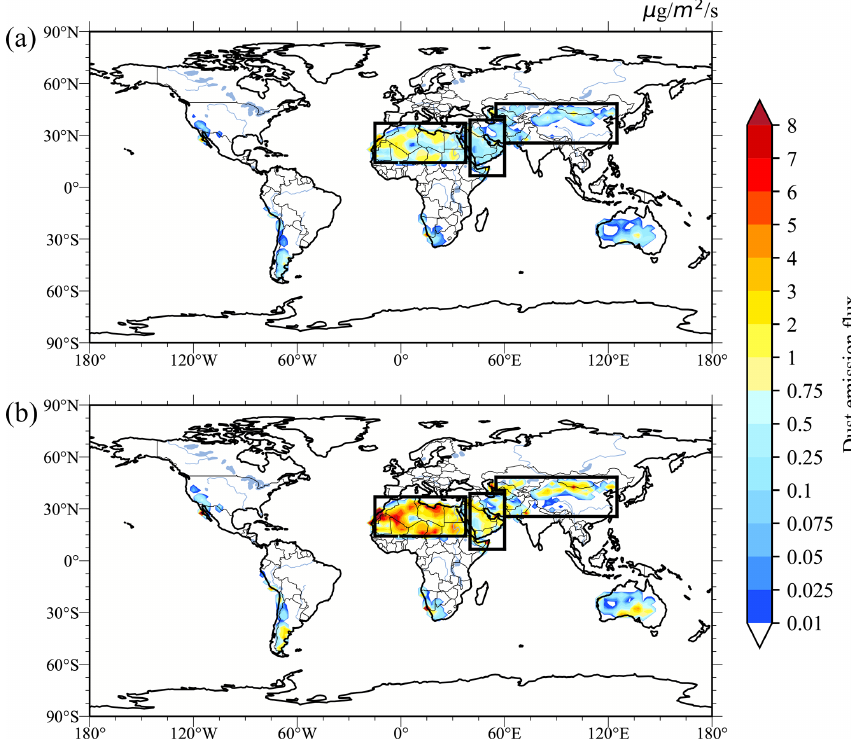
Figure 2. (a) Simulated annual emission flux (µgm − 2 s − 1 ) of dust with a geometric diameter less than 4.5µm in CESM1/CARMA, averaged from February 2014 to January 2018. Panel (b) is same the as panel (a) but for dust with a geometric diameter larger than 4.5µm. The regions of interest are indicated by the black boxes. The coordinates of the three regions are the (1) North African source (20 ◦ W–35 ◦ E and 10.4– 36.9 ◦ N), (2) Middle Eastern source (35–60 ◦ E and 6.6–38.8 ◦ N), and (3) Asian source (55–60 ◦ E for 40.7–48.3 ◦ N and 60–125 ◦ E for 25.5–48.3 ◦